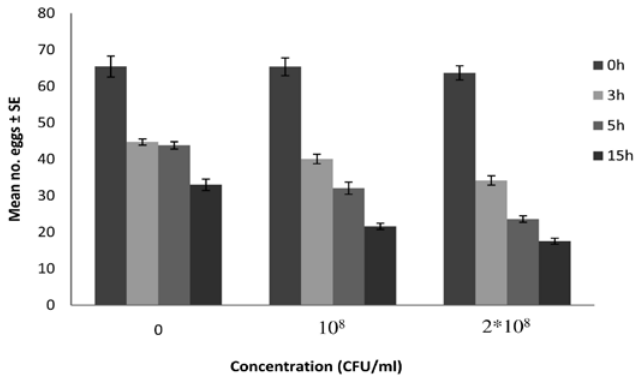
Fig. 1 - Effect of root soaking duration in bacterial suspension of per- centage emerged matured females of phylloxera.